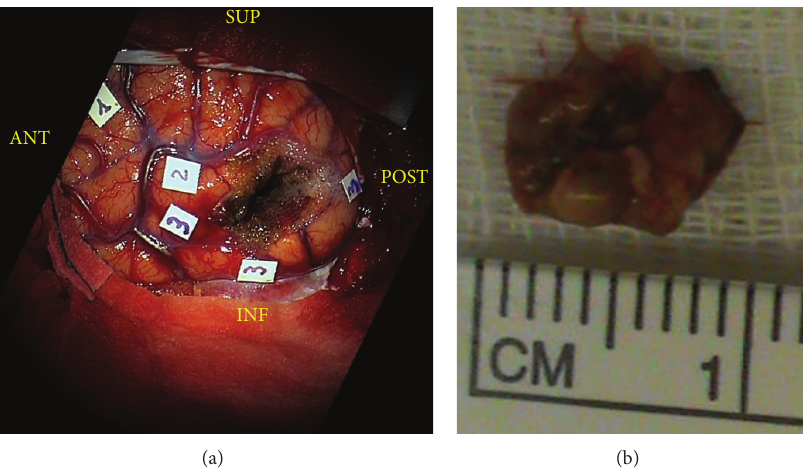
Figure 3: (a) The intraoperative picture after resection shows the results of the direct electrical cortical mapping. The stimulation threshold was set at 3mA after eliciting speech arrest at stimulation of ventral premotor cortex (VPMC) during counting task (tag 1). The cortical stimulation during denomination test (Laiacona-Capitani) elicited semantic paraphasias (tag 3) at the level of the posterior thirds of the inferior temporal sulcus (ITS) and middle temporal gyrus (MTG; BA37 and BA21), at the extreme posterior third of the superior temporal sulcus (STS), posteriorly to the lesion, and at the border between middle and posterior thirds of the STS and superior temporal gyrus (STG; BA22) anteriorly to the lesion. Anomias (tag 2) were elicited at the border between middle and posterior thirds of the STG (BA22) at the upper and anterior margin of the lesion. The site of corticectomy was in the free activations zone in the posterior third of the peri-STS area (BA22). In the deepest part of the surgical cavity direct electrical stimulation elicited semantic paraphasias due to deactivation of the inferior fronto- occipital fasciculus (IFOF). (b) This picture shows the 1cm cavernous angioma (CA) removed. BA: Brodmann area; IFOF: inferior fronto- occipital fasciculus; ITS: inferior temporal sulcus; VPMC: ventral premotor cortex; STG: superior temporal gyrus; STS: superior temporal